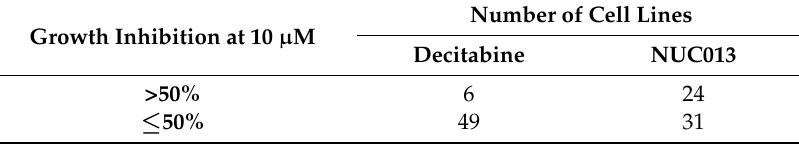
Table 2. Allocation of cell lines of NCI 60 cell line panel treated with decitabine or NUC013 by growth inhibition at 10 µ